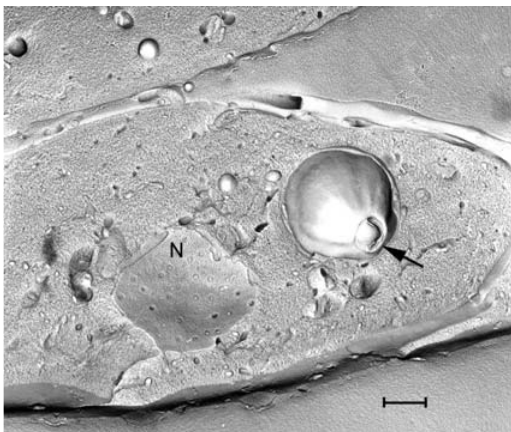
Fig. 2 – Extracellular amastigotes are highly infective to HeLa cells and are promptly visualized in the cytoplasm. Freeze- fracture replica of recently invaded parasite inside a HeLa cell. The parasite flagellar pocket (arrow) can be clearly seen and the nuclear membrane of the host cell (N) identified by the presence of nuclear pores. Bar: 400 µ m.